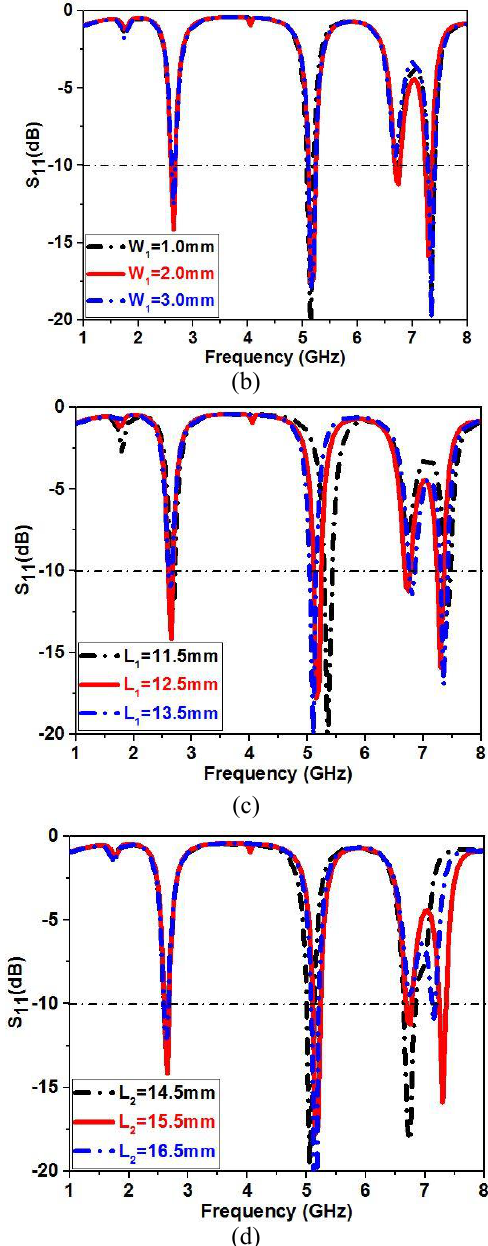
(d) Figure 4. Parametric study of (a) Ground plane (G), (b) Width of left hand side hook-shaped stub (W 1 ), (c) Length of left side hook- shaped stub (L 1 ) and (d) Length of right hook-shaped stub (L 2